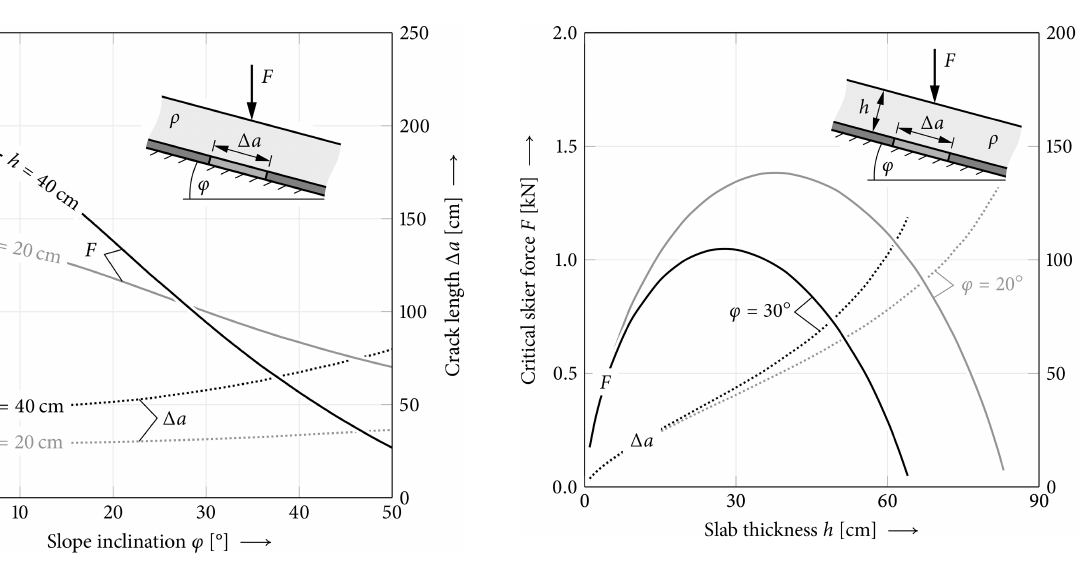
Figure 5. Effect of the slope angle ϕ on the critical additional load- ing F on a defect-free snowpack (solid line) and on the length of predicted initial finite anticrack (cid:49)a (dotted line). Steeper slopes cause a significant reduction of the critical skier force and a moder- ate increase in the crack lengths.